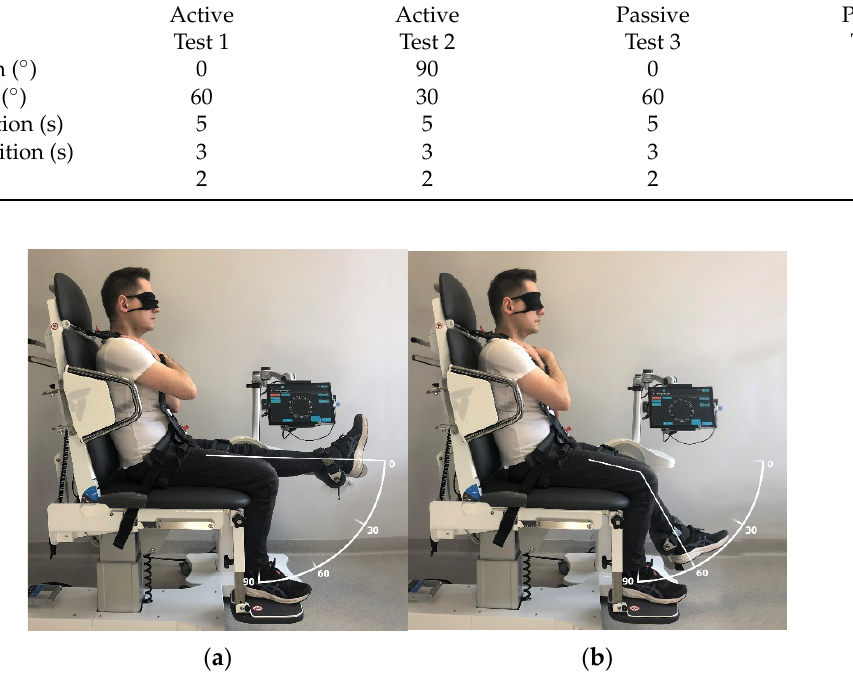
Figure 2. Knee flexion joint position sense (JPS) measurement: ( a ) baseline position; ( b ) target position.